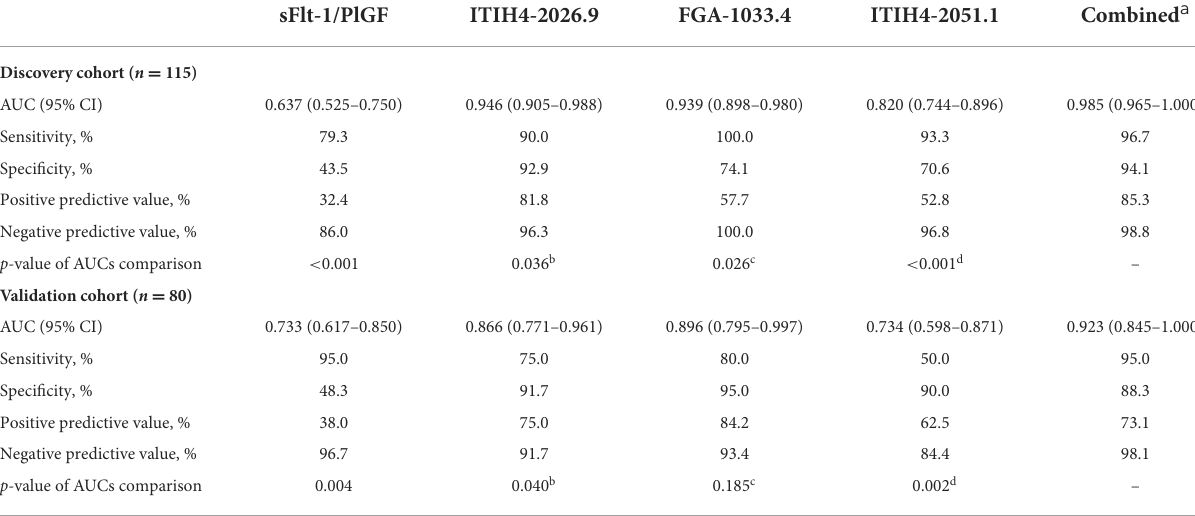
TABLE 3 ROC analysis of the sFlt-1/PlGF and peptide biomarker candidates in preeclampsia